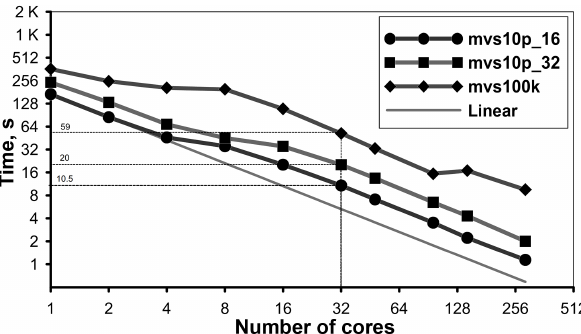
Figure 2. Wall-clock time required for the 10-day ocean– atmosphere model run with disabled physics vs. number of coupler cores on MVS supercomputers (Test I for CMF2.0).